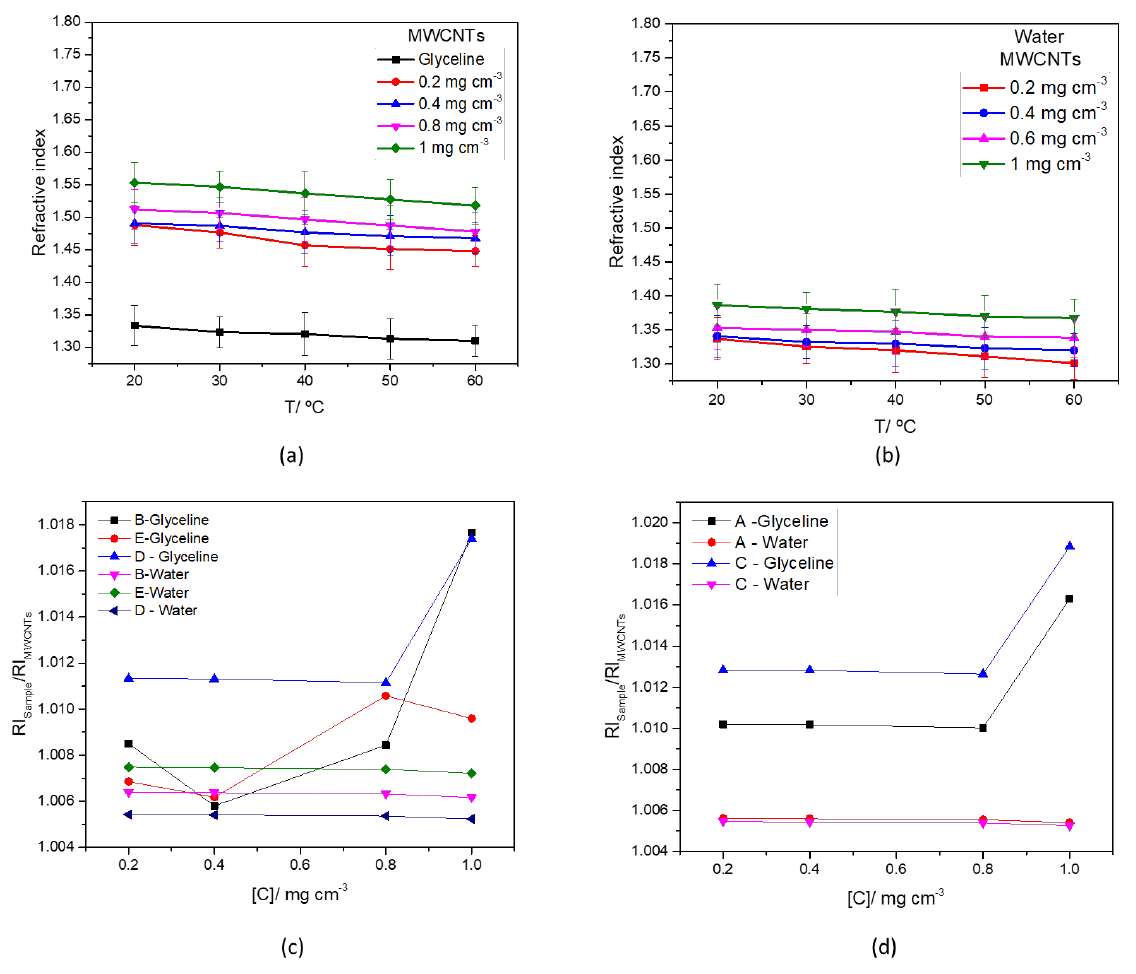
Figure 10. Refractive index of MWCNTs mixtures (0.2–1.0 mg cm − 3 ) in glyceline ( a ), water ( b ) as a function of temperature, and refractive index ratio of AgMWCNTs (0.4 mg cm − 3 ) Samples B, D and E ( c ) and A and C ( d ) as a function of concentration, in glyceline and water. Table 11. Refractive index values for glyceline and water at different temperatures (published and obtained results).